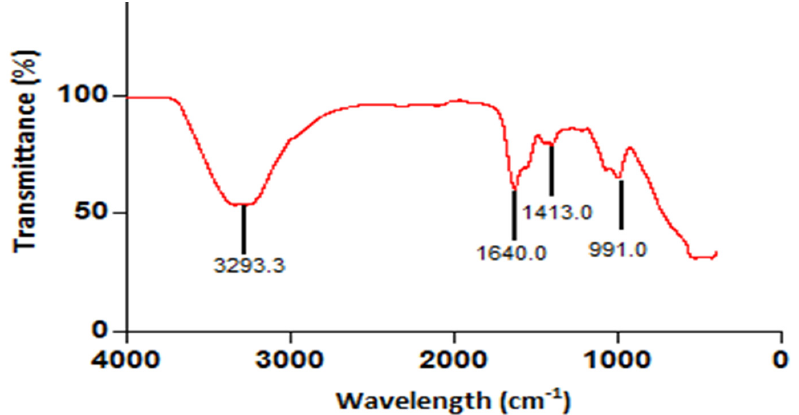
Figure 4. Identification of the functional groups of the extract.